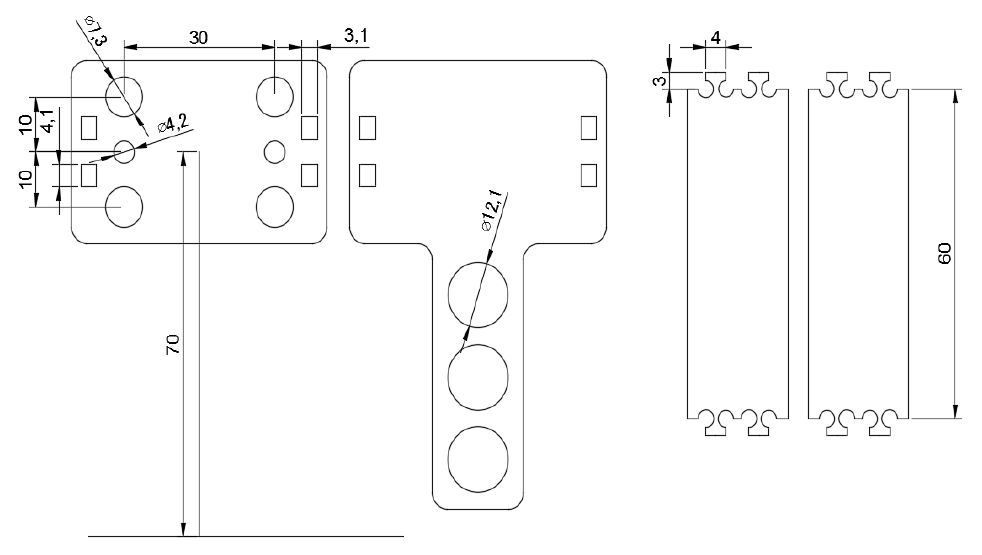
Figure 6. Illuminations using laser source.